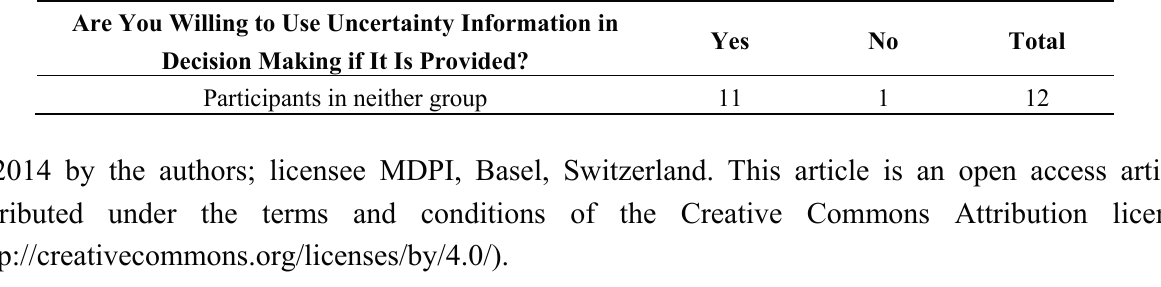
Table A6. Observed frequencies on willingness to use uncertainty information in decision making by participants in neither